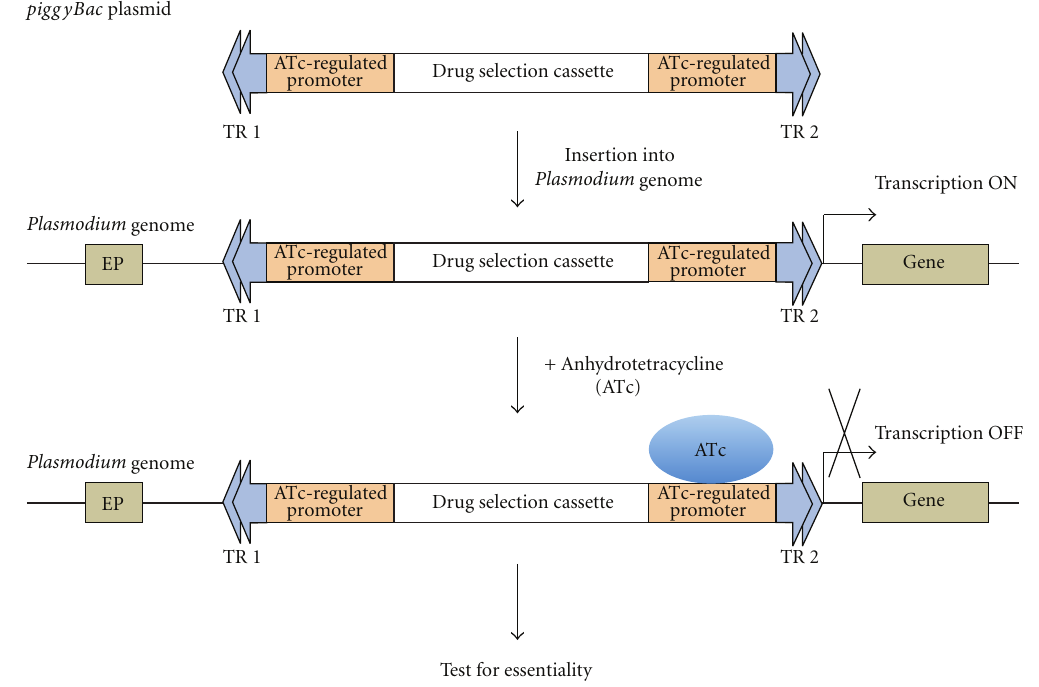
Figure 4: A putative scheme for identifying essential genes in Plasmodium using piggyBac mutagenesis. The piggyBac plasmid containing two anhydrotetracycline-(ATc-) regulated promoters, one near each terminal repeat (TR), can be first inserted into the Plasmodium genome. Upon insertion into the 5 (cid:2) region of a gene, its endogenous promoter (EP) will be replaced by the ATc-regulated promoter. Addition of ATc will block transcription of the gene, allowing the evaluation of its